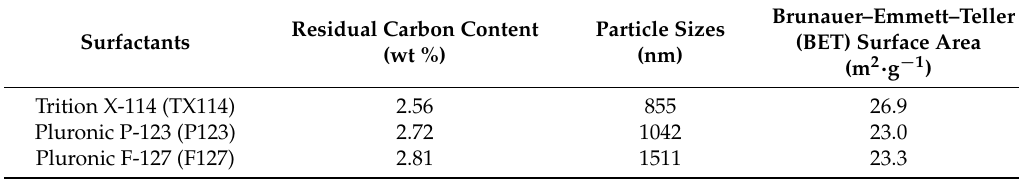
Figure 3. Scanning electron microscope (SEM) images for Mn 3 O 4 /C composites that use ( a ) TX114; ( b ) P123; and ( c ) F127. Table 1. A comparison of the residual carbon content, the particle size and the surface area of Mn 3 O 4 /C powders that use various